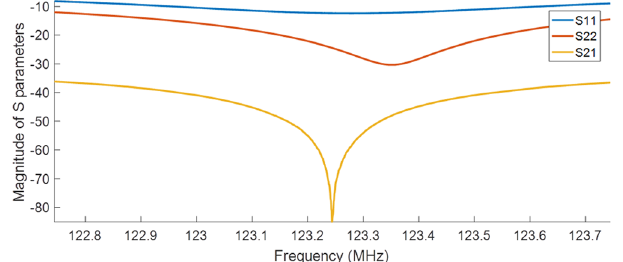
Figure 4. Network analyzer measurement results for the manually tuned analog cancellation circuit using the experimental coil